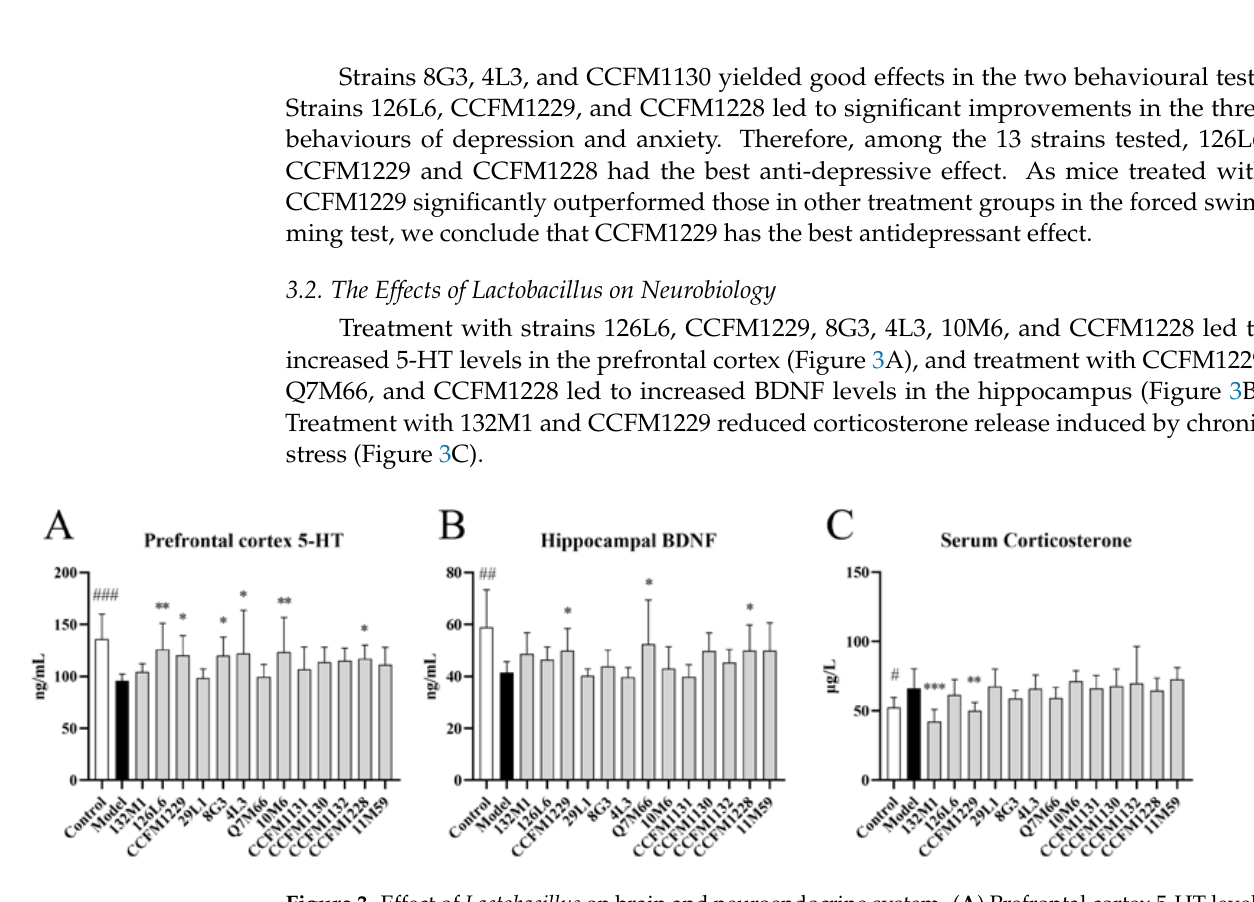
Figure 2. Behavioural tests. # p < 0.05; ## p < 0.01; * p < 0.05; ** p < 0.01; *** p < 0.001; **** p < 0.0001 comparing with depression group; n = 7–9.